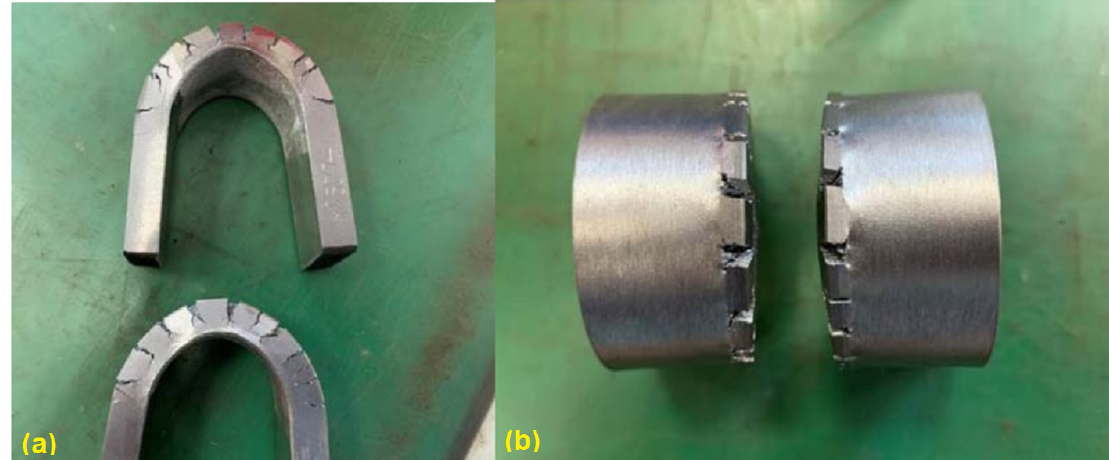
Figure 4. Manual TIG welded sample after side bending: side view ( a ) and top view ( b ).